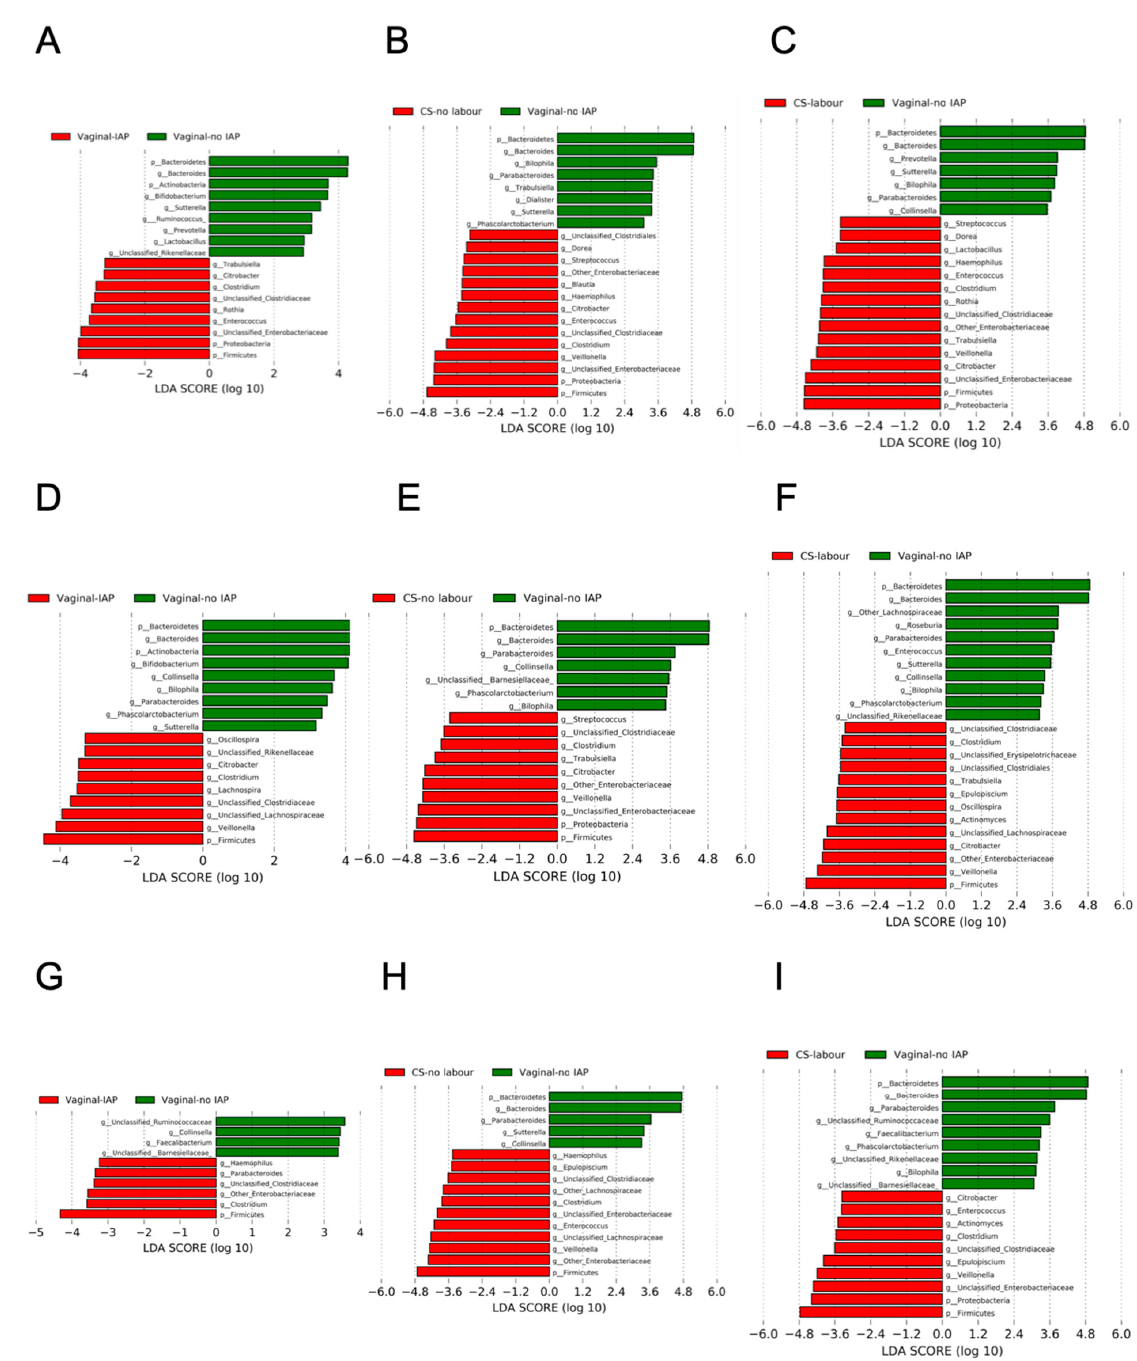
Figure 1. Linear discriminant analysis of 16S gut microbiota by a birth mode within exclusively breastfed ( A – C ), partially breastfed ( D – F ) and non-breastfed ( G – I ) infants at 3